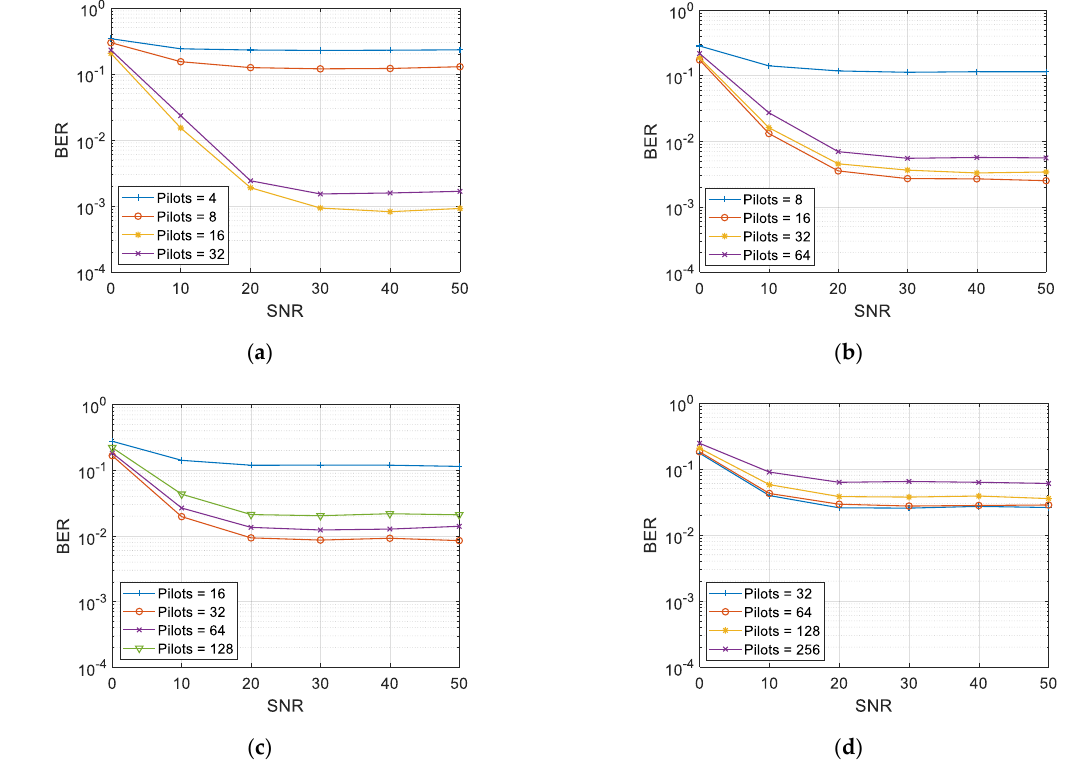
Figure 4. BER as a function of the number of pilots for CP-OFDM with a transmitter-receiver distance of 50 m: ( a ) 64 subcarriers; ( b ) 128 subcarriers; ( c ) 256 subcarriers; ( d ) 512 subcarriers.